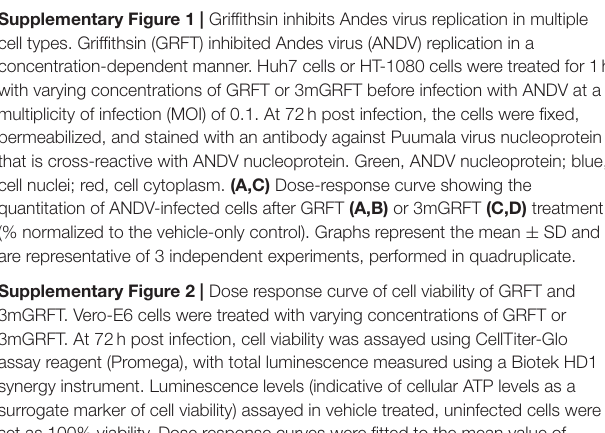
Supplementary Figure 2 | Dose response curve of cell viability of GRFT and 3mGRFT. Vero-E6 cells were treated with varying concentrations of GRFT or 3mGRFT. At 72h post infection, cell viability was assayed using CellTiter-Glo assay reagent (Promega), with total luminescence measured using a Biotek HD1 synergy instrument. Luminescence levels (indicative of cellular ATP levels as a surrogate marker of cell viability) assayed in vehicle treated, uninfected cells were set as 100% viability. Dose response curves were fitted to the mean value of experimentally performed in triplicate.